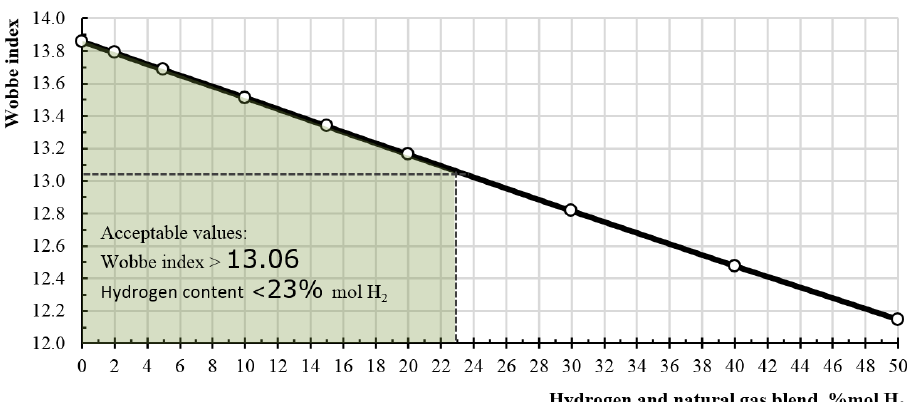
Fig. 2. Wobbe Index based on hydrogen content.